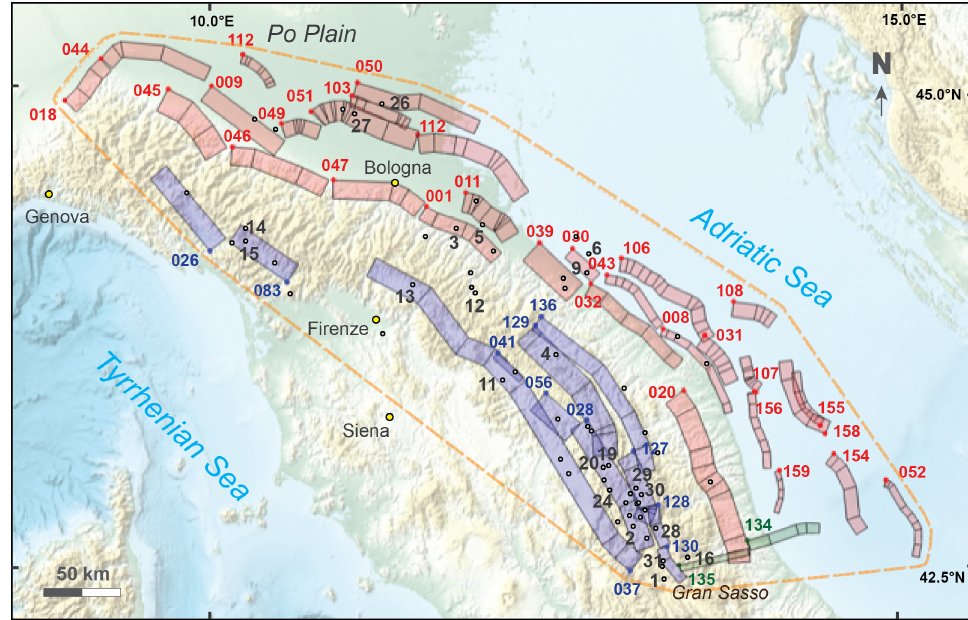
Figure 1. Fault systems and earthquakes. Forty-three DISS (version 3.3.0) seismogenic fault systems are divided into 198 quadrilaterals that best approximate the DISS composite sources, and they are labeled with last three numbers of their DISS-IDs (DISS Working Group [9]). They are shown in accordance with their kinematics (extensional in blue, compressional in red, strike-slip in green), and have colored circles associated with their upper-left corners. Epicentres of the earthquakes from 1650 to 2020 A.D., with M w ≥ 5.5, within a 5 km buffer from faults (dotted line) are shown by black circles. Main shocks of Table 2 are labeled in black (Rovida et al.